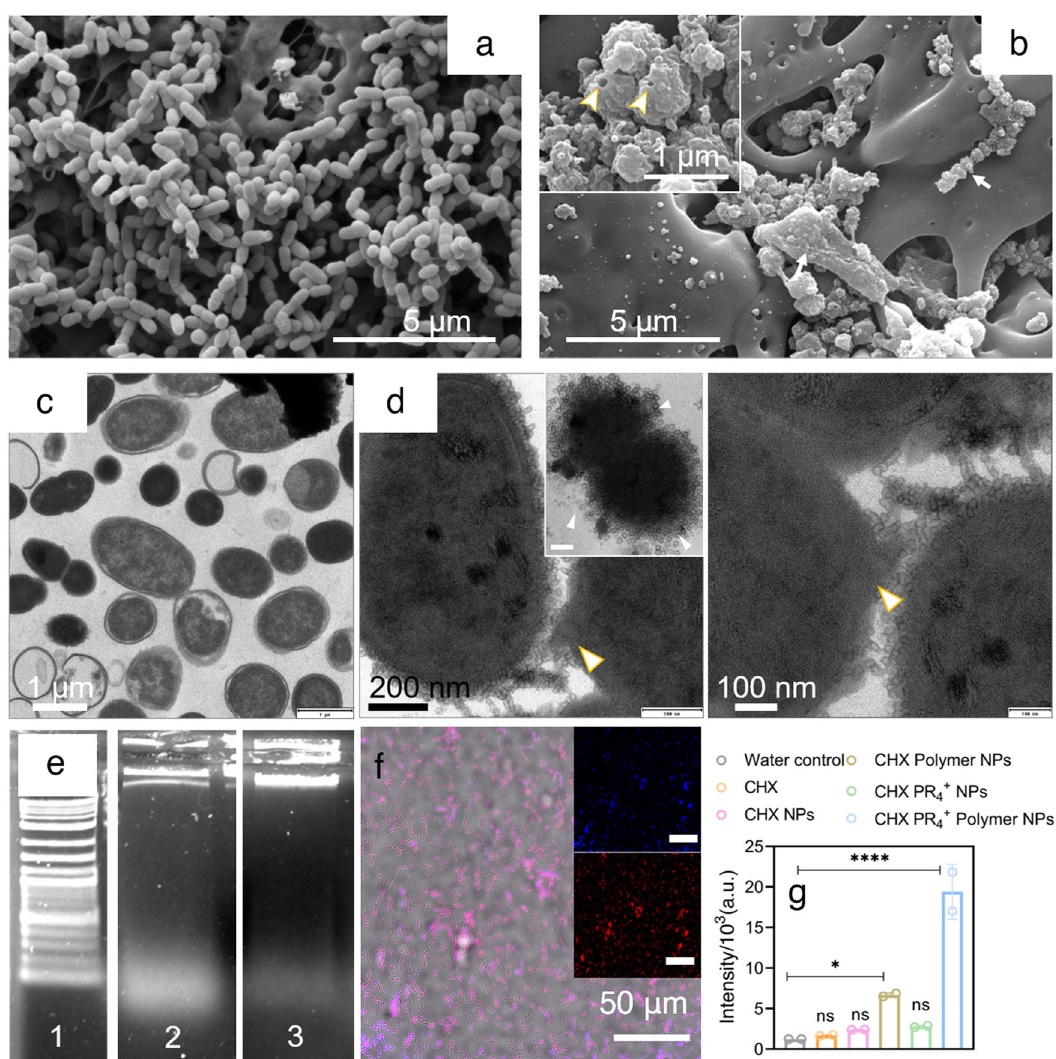
Fig. 4 Antibacterial mechanism governing cell death. SEM images of planktonic S. mutans treated with a water and b CHX PR 4 + polymer NPs with noticeable damage to the membrane and loss of cell morphology; arrows indicate the NPs attached to the bacterial membrane; TEM images of c control, water-treated, and d CHX PR 4 + polymer NP-treated S. mutans . The arrow indicates the damaged membrane, and the arrow in the inset fi gure indicates the NPs on the bacterial outer membrane; e downstream damage to S. mutans as a result of treatment with NPs as investigated with a DNA gel electrophoresis assay, 1: ladder, 2: CHX, and 3: CHX PR 4 + polymer NP treatment; f confocal images from a TUNEL assay of CHX PR 4 + polymer NP treatment, scale bar 50 μ m. All the scale bars are 50 µ m. Blue is the nuclear stain, and red indicates the TUNEL-positive cells. g The TUNEL assay red channel intensity as measured by plate reader. Ordinary one-way ANOVA w.r.t. water, p values < 0.1 and 0.0001 are indicated by * and ****, respectively. Error bar represents mean ±